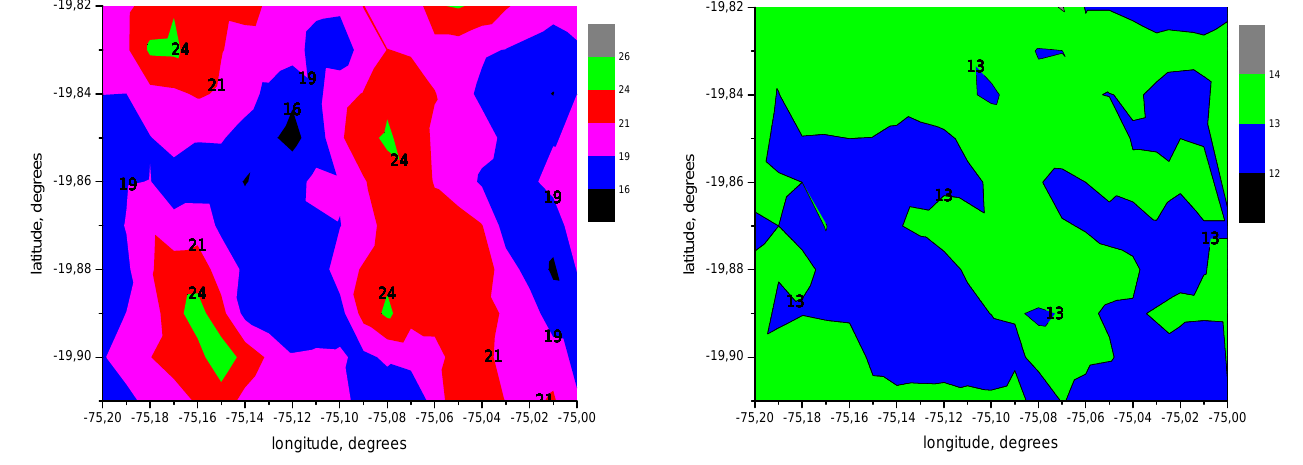
Fig. 9. The map of COT retrieved using PEROMT.